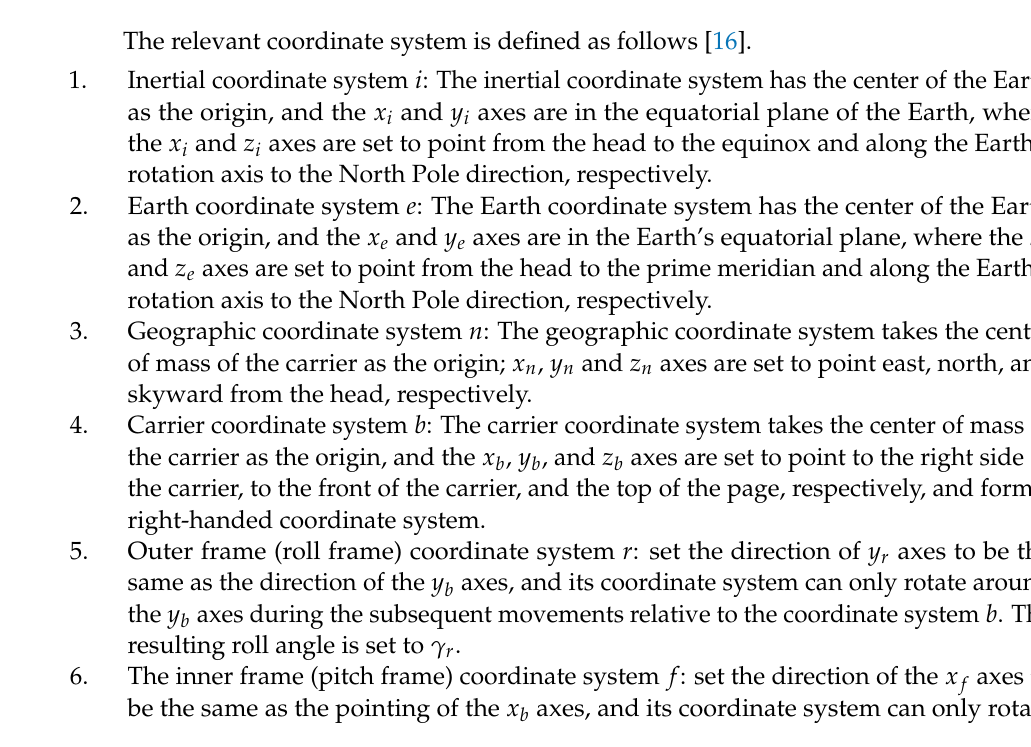
Figure 2. Stabilization platform mechanical structure.